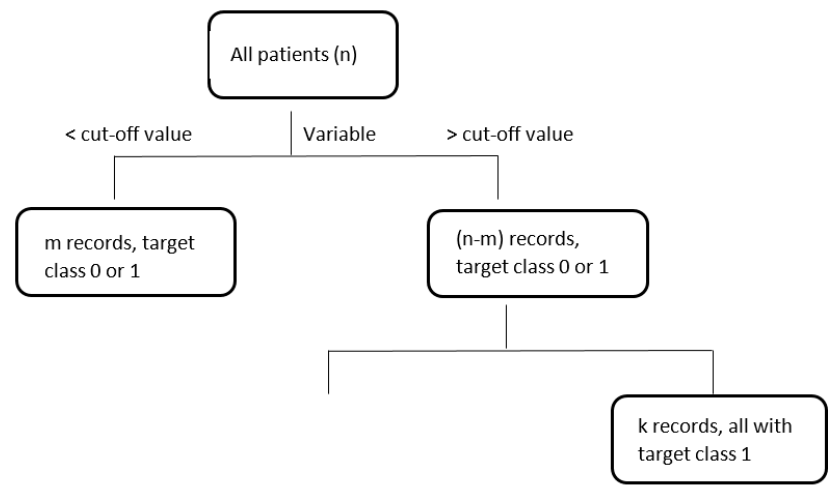
Figure 1. An example of decision tree.